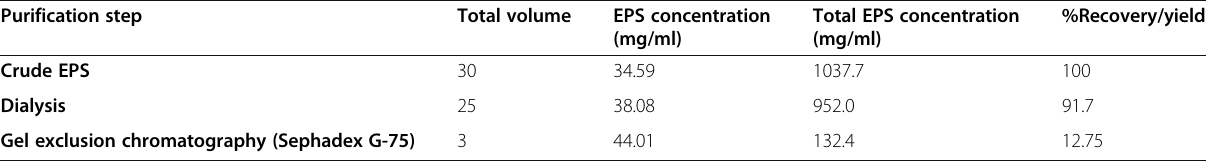
Table 1 Purification profile of exopolysaccharide from L. paraplantarum KM1 Purification step